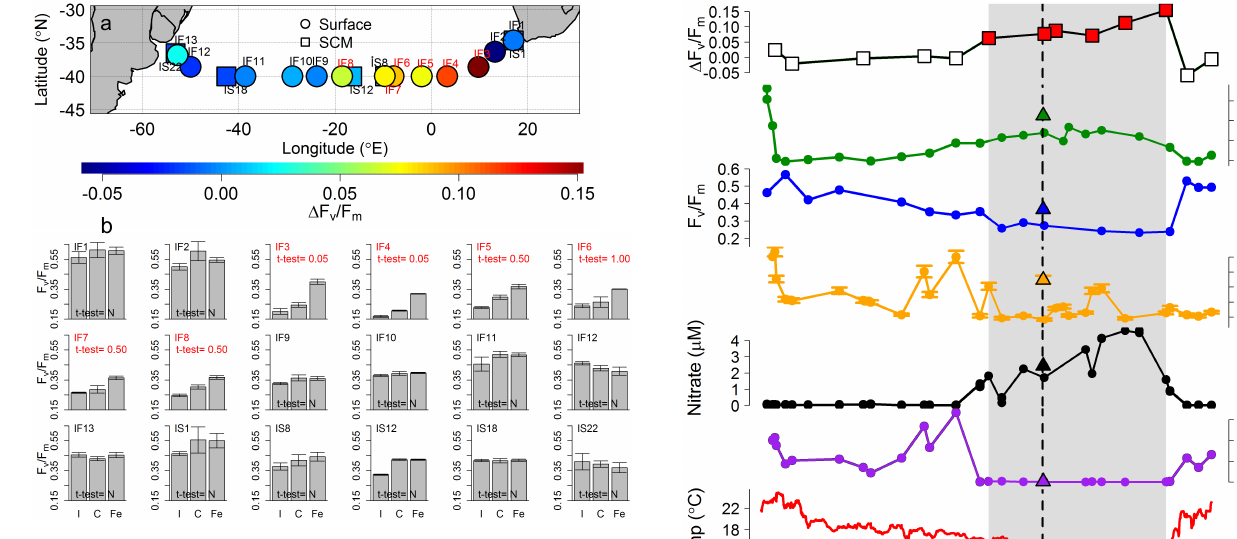
Fig. 7. Fe incubation locations and results. (a) Locations of experi- ments coloured according to 1F v / F m values ( 1F v / F m = F v / F m Fe amended bottle – F v / F m control bottle). IF = Incubation Fish (indicating trace-metal-clean tow-fish water used for the experi- ment, highlighted on the map as a filled circle), IS = Incubation Station (indicating SCM trace-metal-clean water from the titanium CTD rosette was used, highlighted on the map as a filled square). Experiments with statistically significant responses ( t test p < 0.01) are highlighted with red labels. (b) F v / F m for incubation experi- ments. I = Initial, C = Control (incubated for 24h with no amend- ment), Fe = Fe spiked (incubated for 24h after 2nmolL − 1 FeCl 3 addition). Bars = mean of three bottle replicates; error bars = stan- dard deviation. Student’s one tailed t test significance levels (%) are shown, with significant results labelled in red (N = no significant difference between control and Fe amended bottles).